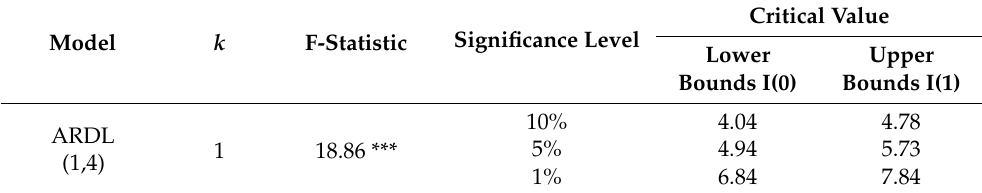
Table 4. Results of the bounds